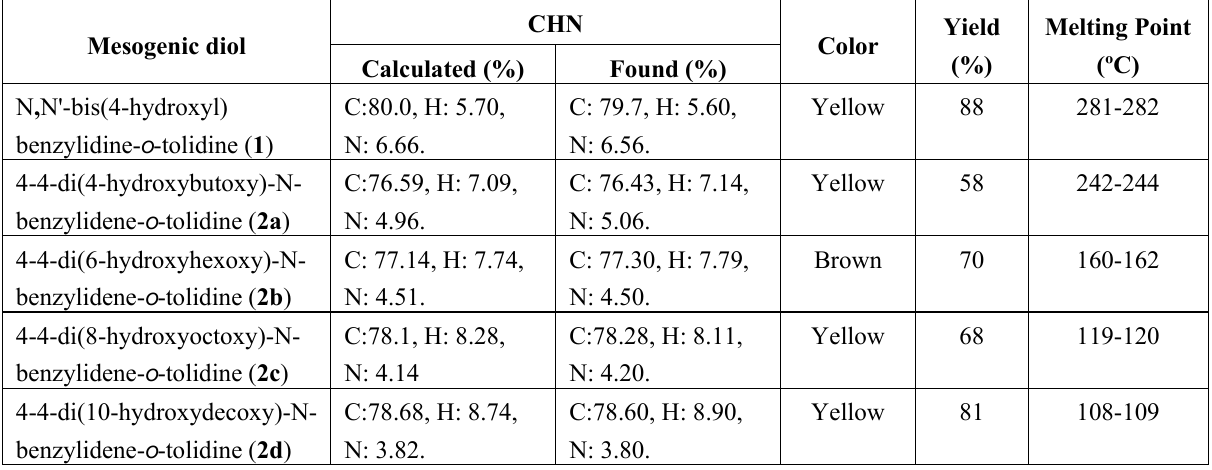
Table 1. Physical properties and CHN data for diols 2 (a–d